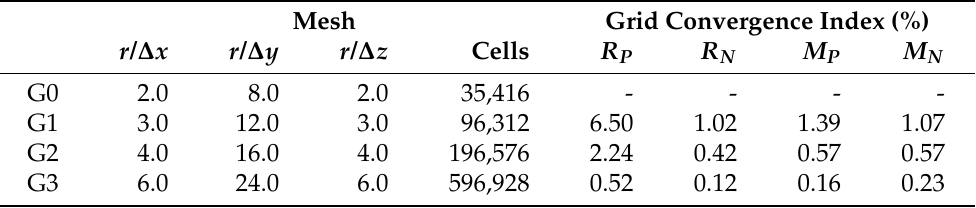
Table 2. Grid convergence index for the fluidic LEM parameters. Symbols are the same as in Table